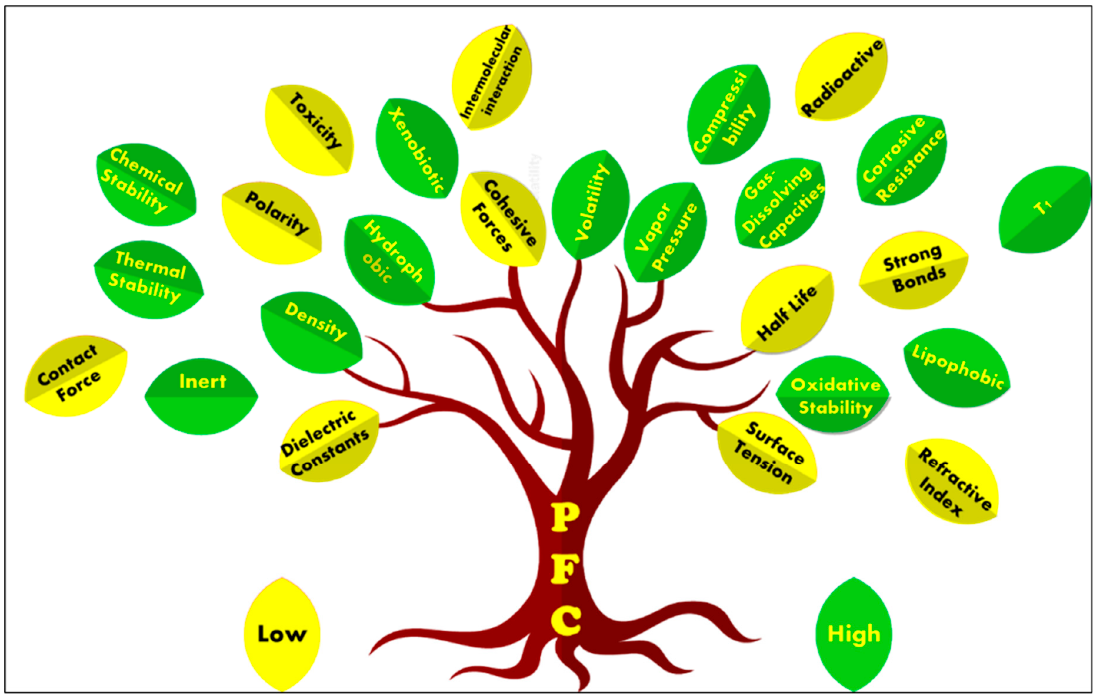
Figure 1. The unique properties of perflurocarbon compounds represented by a tree and its leaves. The green leaves represent the properties of PFC in which the values are higher, and the yellow leaves represent lower